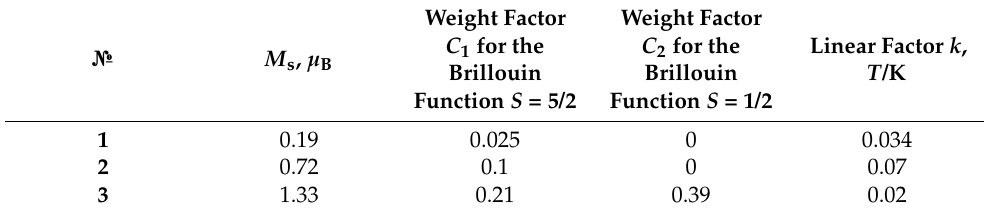
Table 2. Fitting parameters for M ( H ) for 1 , 2 , and 3